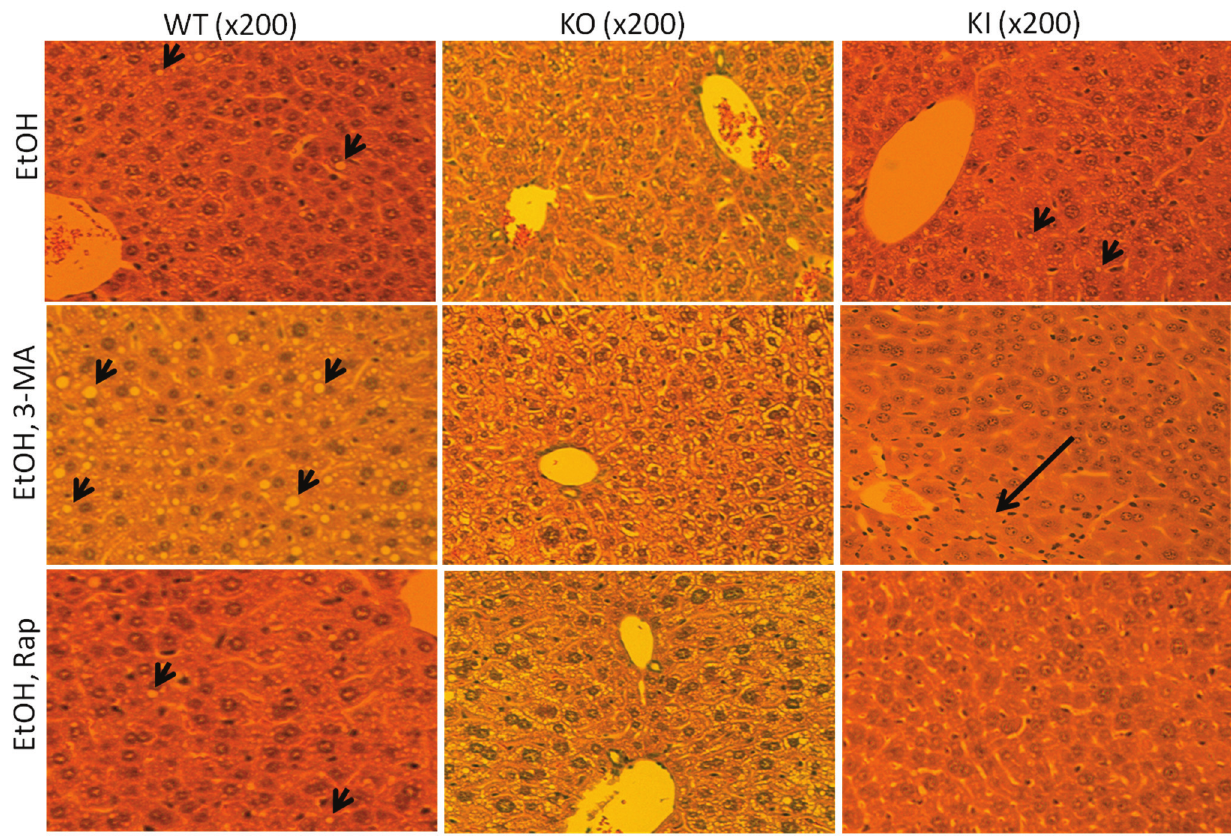
Figure 2. 3-MA enhances liver toxicity in WT mice and KI mice whereas rapamycin is protective against liver injury. Chronic alcohol fed WT, KO and KI mice were treated with saline, 3-MA or rapamycin as mentioned in the legend to Figure 1. Liver slides were prepared for H&E staining and the extent of liver injury including steatosis and necrosis was observed under a light microscope. Arrowheads point to lipid droplets, and the arrow points to